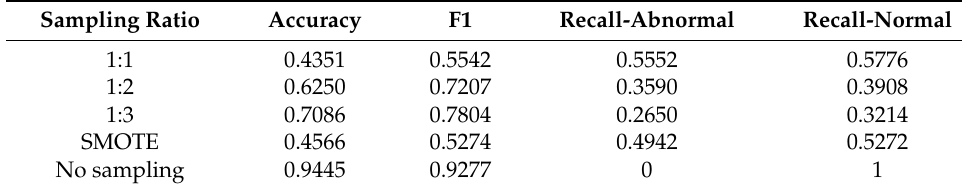
Table 6. Results for different sampling ratios.